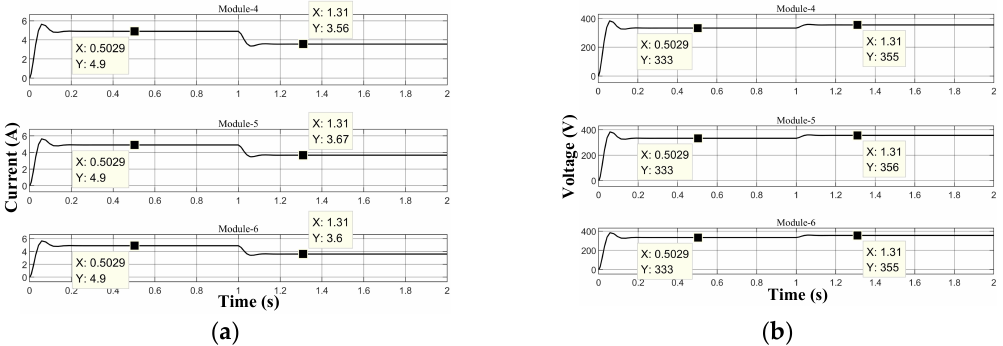
Figure 11. Simulation results of combined converter 2 under condition 2: ( a ) input current of the modules and ( b ) output voltage of the modules.